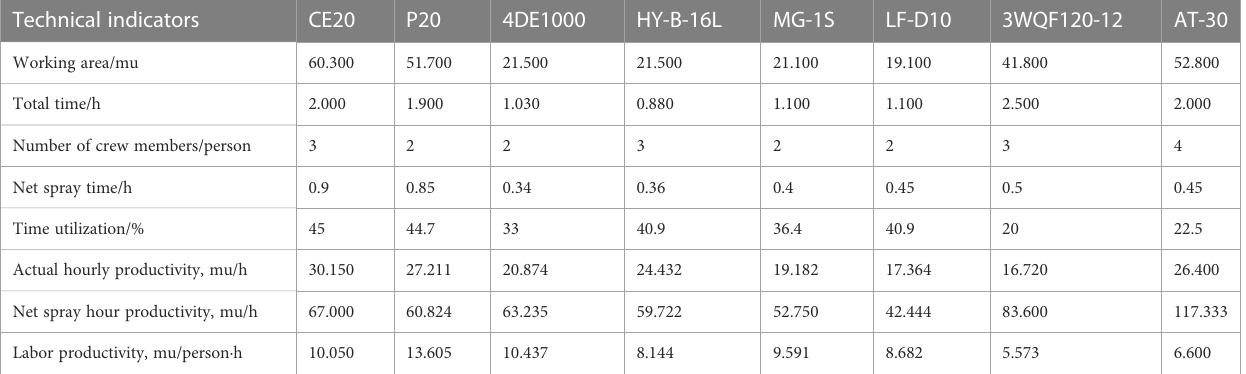
TABLE 3 Productivity technical indicators of different types of plant protection UAVs.